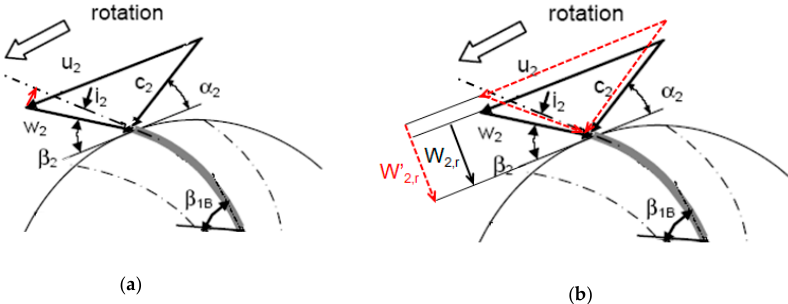
Figure 24. Runner losses: ( a ) the flow incidence loss; ( b ) variation of the radial component of the inlet relative velocity.